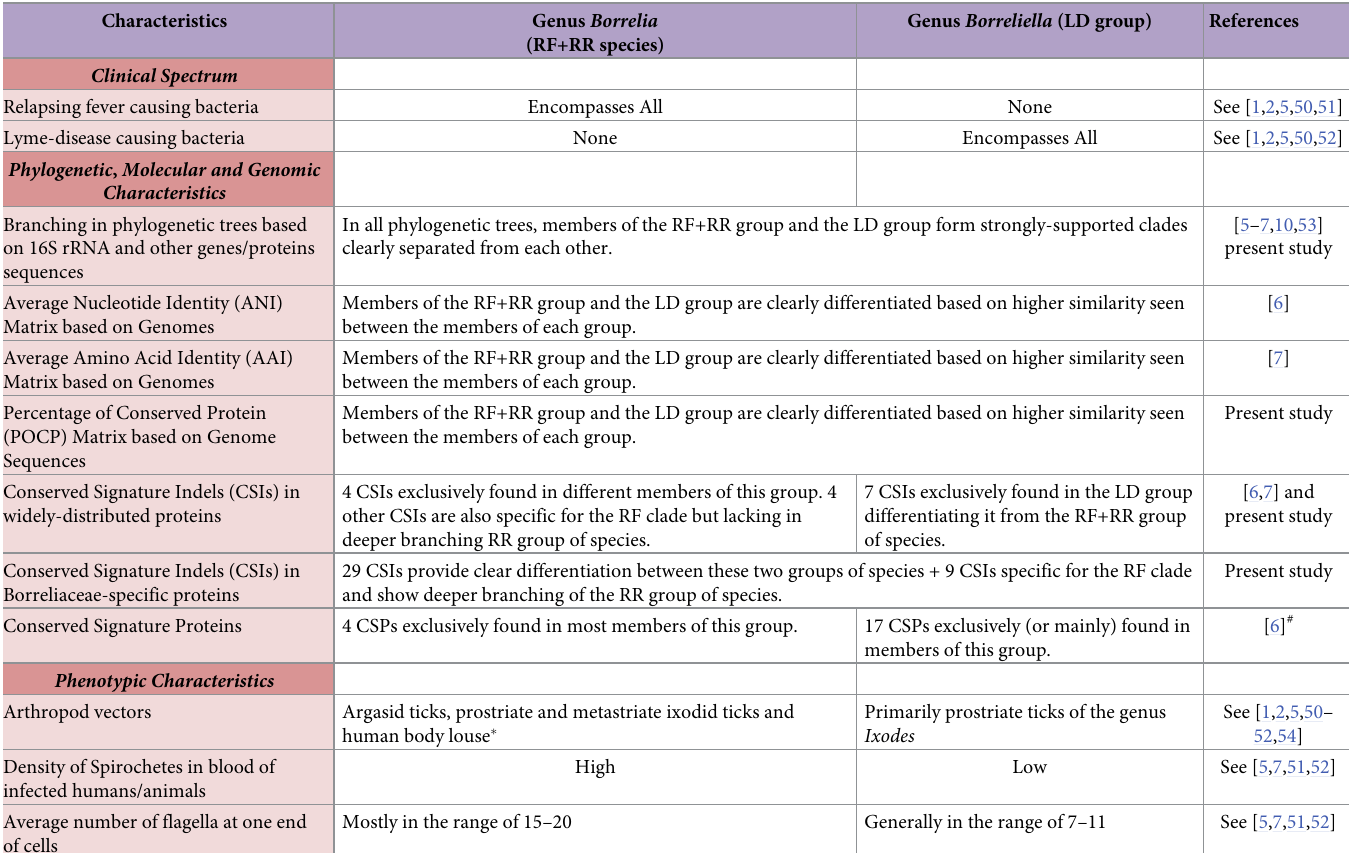
Table 4. Clinical, molecular and phenotypic differences between members of the RF-RR group (genus Borrelia ) and the Lyme disease group (genus Borreliella